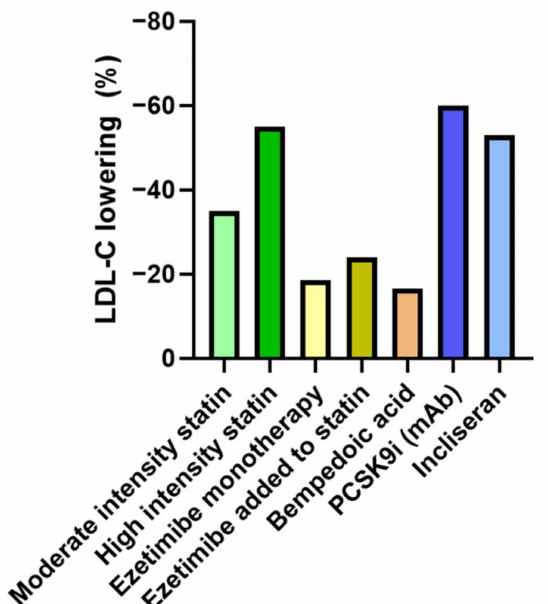
Figure 2. Approximate LDL-C reduction with selected lipid-lowering drugs. Approximate and/or average LDL-C reductions with selected agents are shown. High intensity statins include atorvastatin 40 to 80 mg/day and rosuvastatin 20 to 40 mg/day [3]; percentage LDL-C reductions are abstracted from the results of the Statin Therapies for Elevated Lipid Levels compared Across doses to Rosuvas- tatin (STELLAR) trial [4], with depicted examples of achieved LDL-C reduction using rosuvastatin 40 mg/day (high intensity statin) and simvastatin 20 mg (moderate intensity statin). The effects of ezetimibe monotherapy (cited in Mach et al. [5]) and the additional LDL-C reduction when combined with statin therapy in the IMPROVE-IT trial [6] are shown. Bempedoic acid therapy is discussed later in the work. The effects of PCSK9 inhibitor therapies including monoclonal antibody (mAb) agents (evolocumab and alirocumab) [5] and the small interfering RNA (siRNA) agent incliseran [7] are